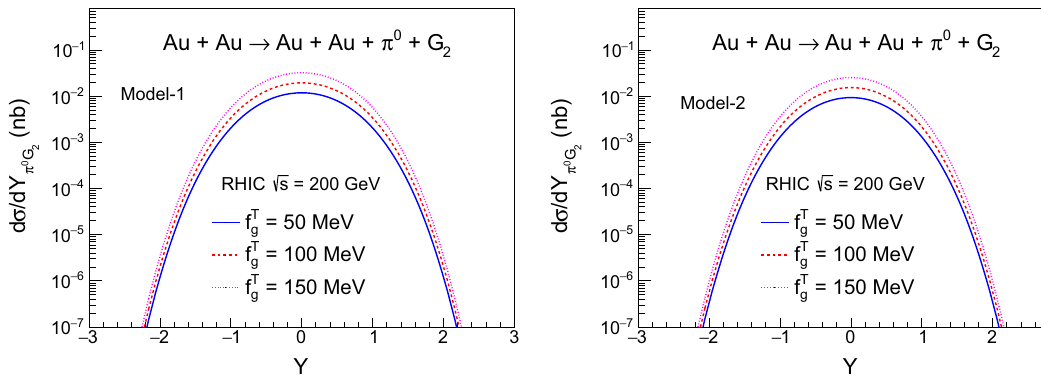
Fig. 3 Rapidity distributions for the UPC process Au + Au → Au + Au + G 2 + π 0 at RHIC with model-1 (left panels) and model-2 (right √ s = 200 GeV. The solid, dashed and dotted lines correspond to f T g = 50 MeV, 100 MeV and 150 panels). The center of mass energies is